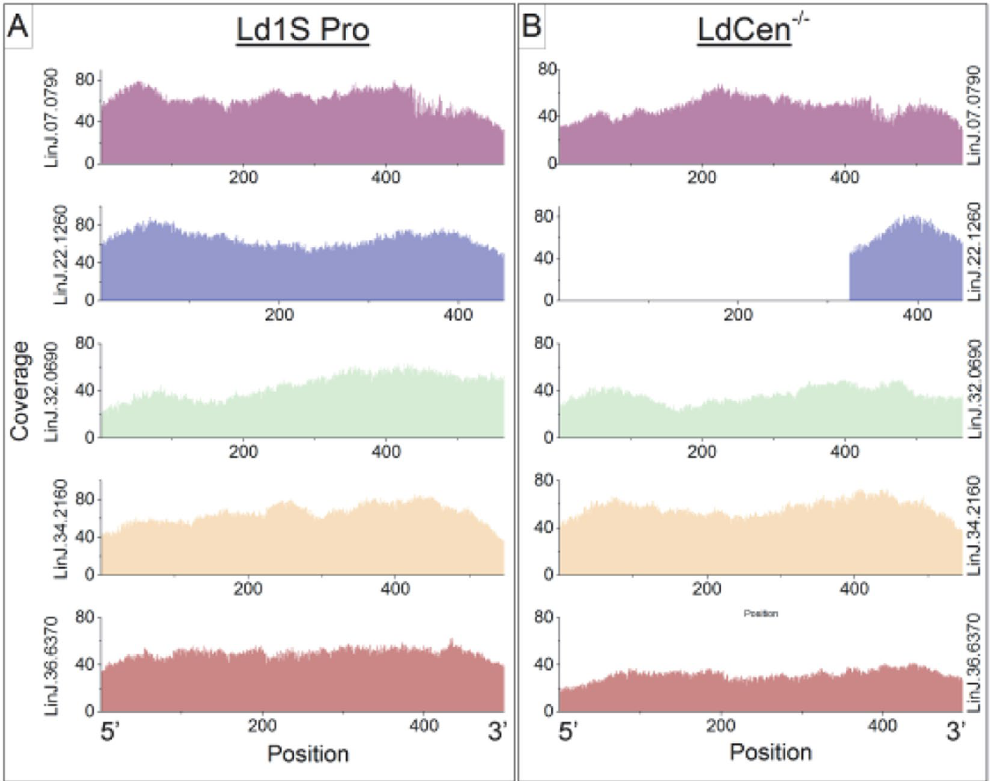
Figure 2. Sequence coverage of various Centrin homologs in LdWT and LdCen − / − genomes. Coverage maps of LdWT ( A ) and LdCen − / − ( B ) reads aligned against various Centrin homologs located on LinJ.07, LinJ.22, LinJ.32, LinJ.34, and LinJ.36 chromosomes. ( A ) All five centrin genes are covered in LdWT . ( B ) The centrin gene located on chromosome 22 (LinJ.22) is not covered, as expected, in the sequencing data from the LdCen − / − mutant. All other centrin genes are covered in the sequence data in LdCen − / −